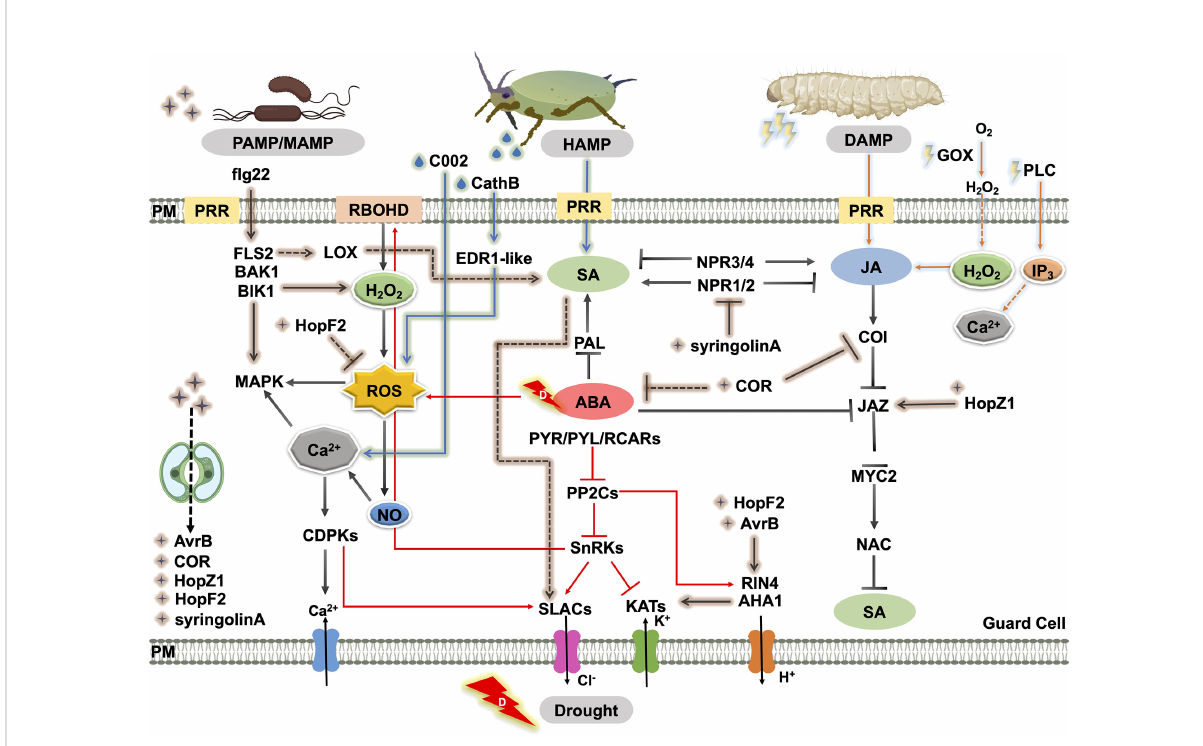
FIGURE 3 Schematic representation of the crosstalk of biotic and abiotic responses through the regulation of stomatal movement. MAMPs or PAMPs are perceived by receptors like PRRs. This recognition triggers plant immunity and elevates the SA level, which promotes the production of secondary messengers such as ROS, NO, and Ca 2+ . ROS accumulation leads to stomatal closure. As a counter defense, virulence factors or effectors produced by the pathogen such as COR, syringolinA, T3SEs, AvrB, HopX1, HopF2, and HopZ promote stomatal reopening by manipulating downstream ion channels or inhibitory effects on SA biosynthesis and SA signaling. Piercing or chewing insect attack triggers stomatal closure by mainly activating SA and JA signaling, respectively. Insect saliva enzymes and effectors such as GOX, PLC, CathB, and C002 also induce herbivory-induced stomatal closure via elevated ROS, Ca 2+ , and H 2 O 2 levels. ABA affects insect-attack defense or pathogen- induced plant immunity by interacting with SA and JA. Straight and dashed arrows indicate direct and indirect interactions, respectively. Pointed and blunt arrows indicate activated and inhibited processes, respectively. Abbreviations, plant proteins: PLC, phospholipase c; RBOHD, respiratory burst oxidase homologou protein d; LOX, lipoxygenase; FLS2, fl agellin-sensitive 2; BAK1, brassinosteroid insensitive 1-associated kinase 1; BIK1, Botrytis-Induced Kinase 1; MAPK, mitogen-activated protein kinase; CDPK, Ca 2+ -dependent protein kinases; PP2C, protein phosphatase 2C; SnRK, snf1-related protein protein kinase; SLAC, S-type anion channels; KAT, guard cell inwardly rectifying K + channel; AHA, H + -ATPase; RIN4, rpm1 interacting protein 4; COI, coronatine insensitive; JAZ, jasmonate ZIM domain; MYC2, basic-helix-loop-helix transcription factor 2; NAC, NAC domain containing protein; PAL, phenylalanine ammonia lyase; PYR/PYL/RCAR, pyrabactin resistance/ pyrabactin resistance-like/regulatory component of aba receptor; NPR, non-expressor of pathogenesis-related genes; ABCG, Arabidopsis thaliana ATP-binding cassette G; EDR1-like, enhanced disease resistance 1-like protein. Insect effectors: C002, effector detected in aphids; CathB, cathepsin b; GOX, glucose oxidase; PLC, thephospholipase C. Pathogen effectors: COR, coronatine; HopM1/HopF2, type-III-secretion- system effectors; XopR, effector of Xanthomonas oryzae ; AvrB/HopZ1/HopX1, effector of Syringa protolaciniata